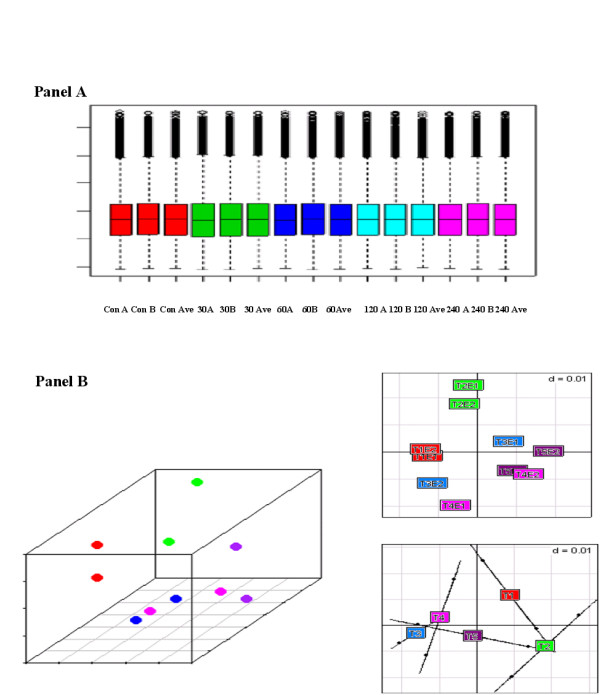
Global Changes in osteoblast gene expression in response to dexamethasone. Gene expression was assessed using Affymetrix HG-U133A oligonucleotide microarrays. Panel A shows boxplot of normalised data and computed average arrays for each time point. Panel B shows a principal components analysis plot of all arrays.